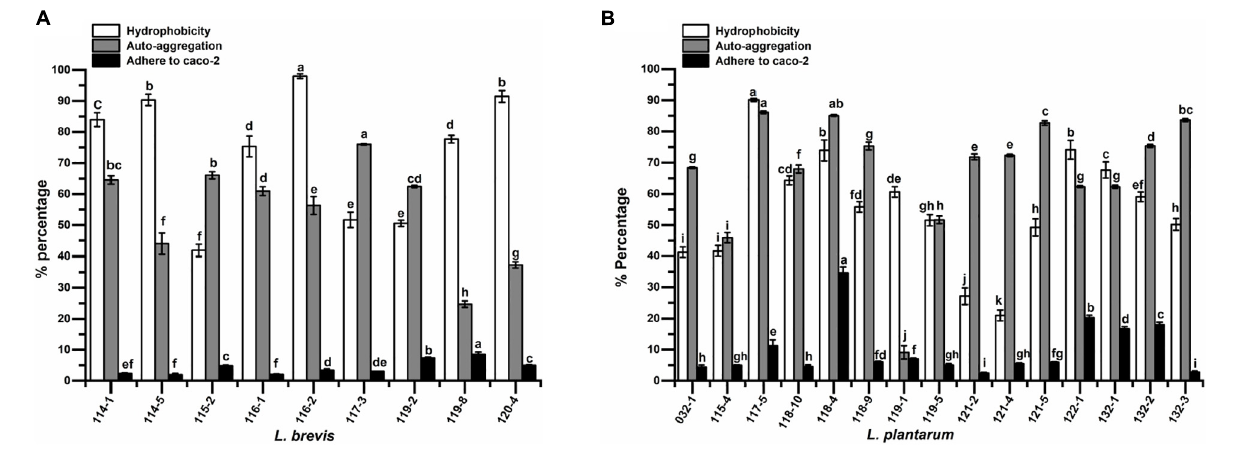
FIGURE 2 | The hydrophobicity, auto-aggregation, and adhesion ability to Caco-2 cells of (A) Lactobacillus brevis strains and (B) Lactobacillus plantarum strains isolated from fermented vegetables in Shaanxi, China. Data shown are mean ± SD of triplicate values of independent experiments. Different letters indicate significantly different means (P <